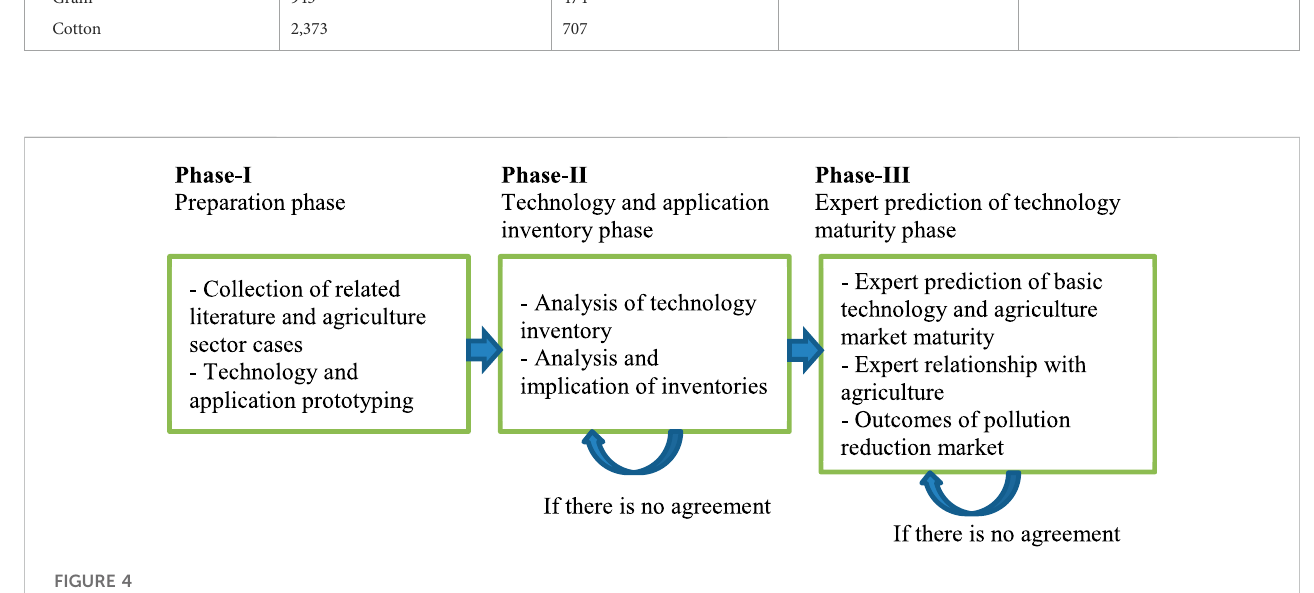
FIGURE 4 Technology roadmap process in the agriculture